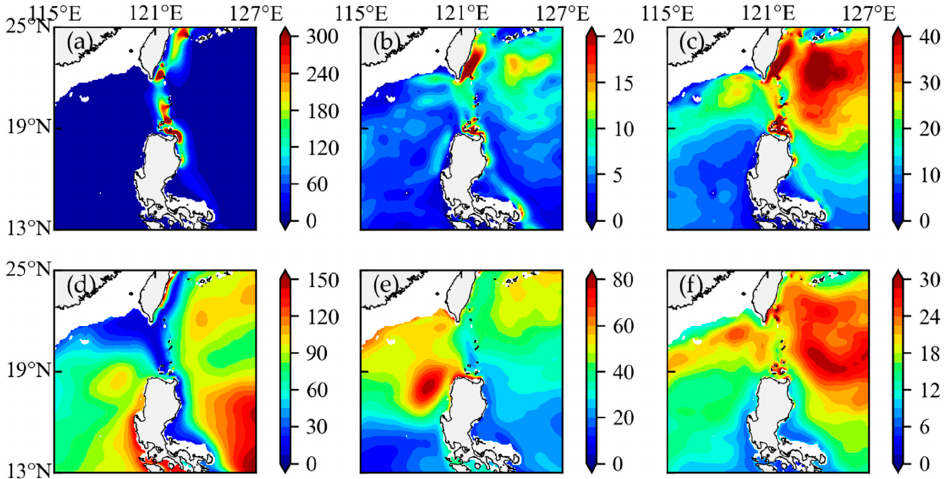
Figure 6. Temporally (1996–2015) and vertically (upper 266 m) averaged multiscale KE and APE components (Jm − 3 ). ( a ) CKE; ( b ) SKE; ( c ) EKE; ( d ) CAPE; ( e ) SAPE; ( f ) EAPE. Figure 6d–f shows the horizontal distributions of multiscale APE components. Note